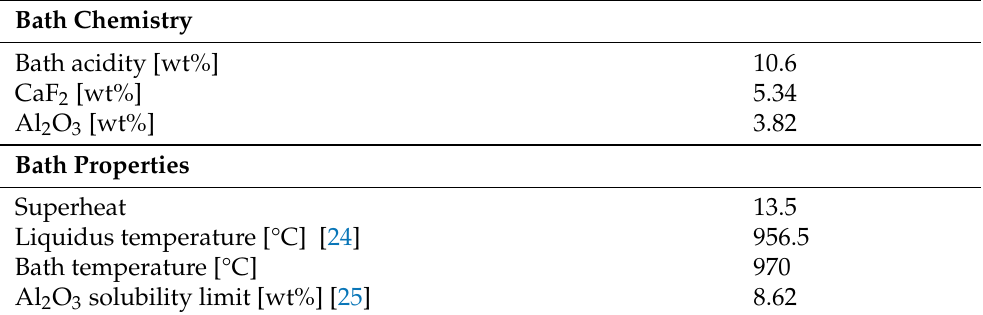
Table 3. Chemistry and calculated properties of the industrial bath at initial